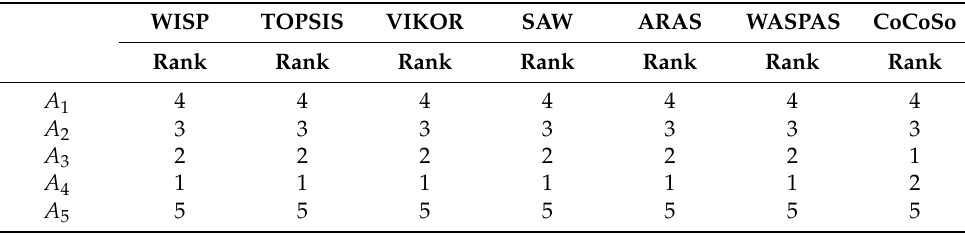
Table 24. Ranking orders obtained using selected MCDM methods.